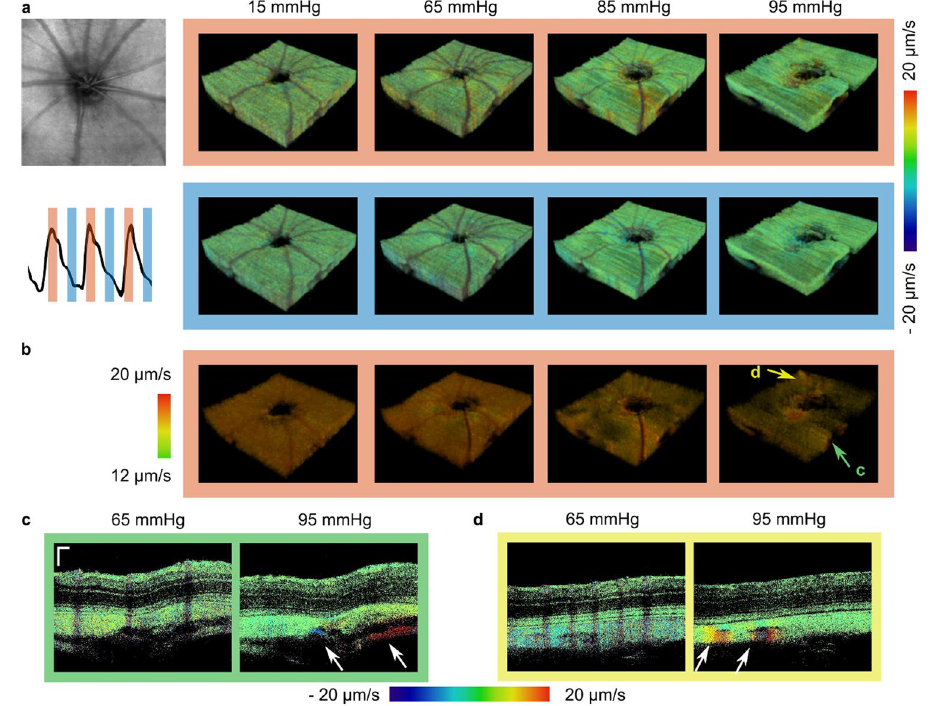
Figure 5. Time gated visualization of ocular fundus pulsations. ( a ) The recorded volumes were time gated according to the heart cycle for visualization. The top row shows 3D renderings of the CS complex at four different IOP levels ranging from 15 mmHg to 95 mmHg at the instance of maximum deformation. The bottom row shows the corresponding volumes at half a heart cycle later. ( b ) Volumes are shown for motions exceeding 12 μ m / s for the same datasets as shown in ( a ). Locally increased deformations were identified at higher IOP levels while the overall pulsatility decreased with increased IOP above 65 mmHg. ( c , d ) B-scans at the locations indicated by arrows in ( b ) are shown at IOPs of 65 mmHg and 95 mmHg, respectively. Regions undergoing increased deformations were identified around the ONH and larger choroidal vessels. (scale bar = 100 μ m ).